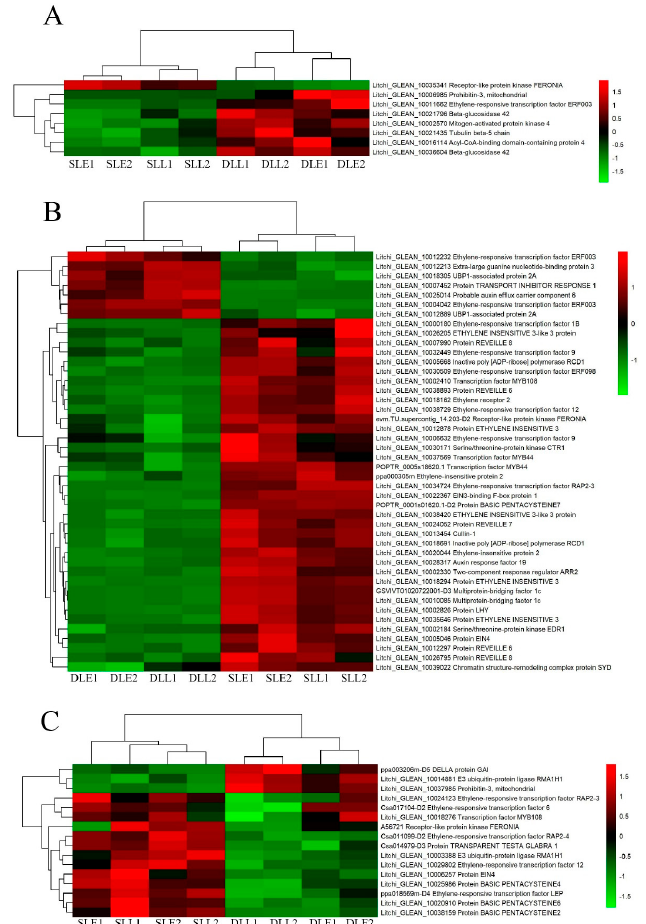
Figure 3. Heat map diagram showing the ethylene-related differentially expressed genes (DEGs) between senescing and developing panicle leaves. ( A ) The unique DEGs expressed at an early stage. ( B ) The DEGs simultaneously expressed at early and later stages. ( C ) The unique DEGs expressed at a later stage. Litchi trees were transferred to a growth chamber at 18 ◦ C to induce panicle leaf senescence when panicle primordia emerged. The other trees were transferred to a growth chamber at 26 ◦ C to encourage panicle leaf development. Fragments per kilobase of transcript per million mapped read (FPKM) values of the samples were normalized to Z-score.